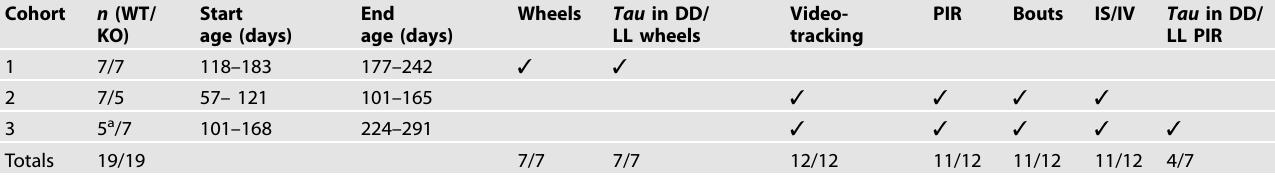
Table 1. Cohorts of mice used for circadian